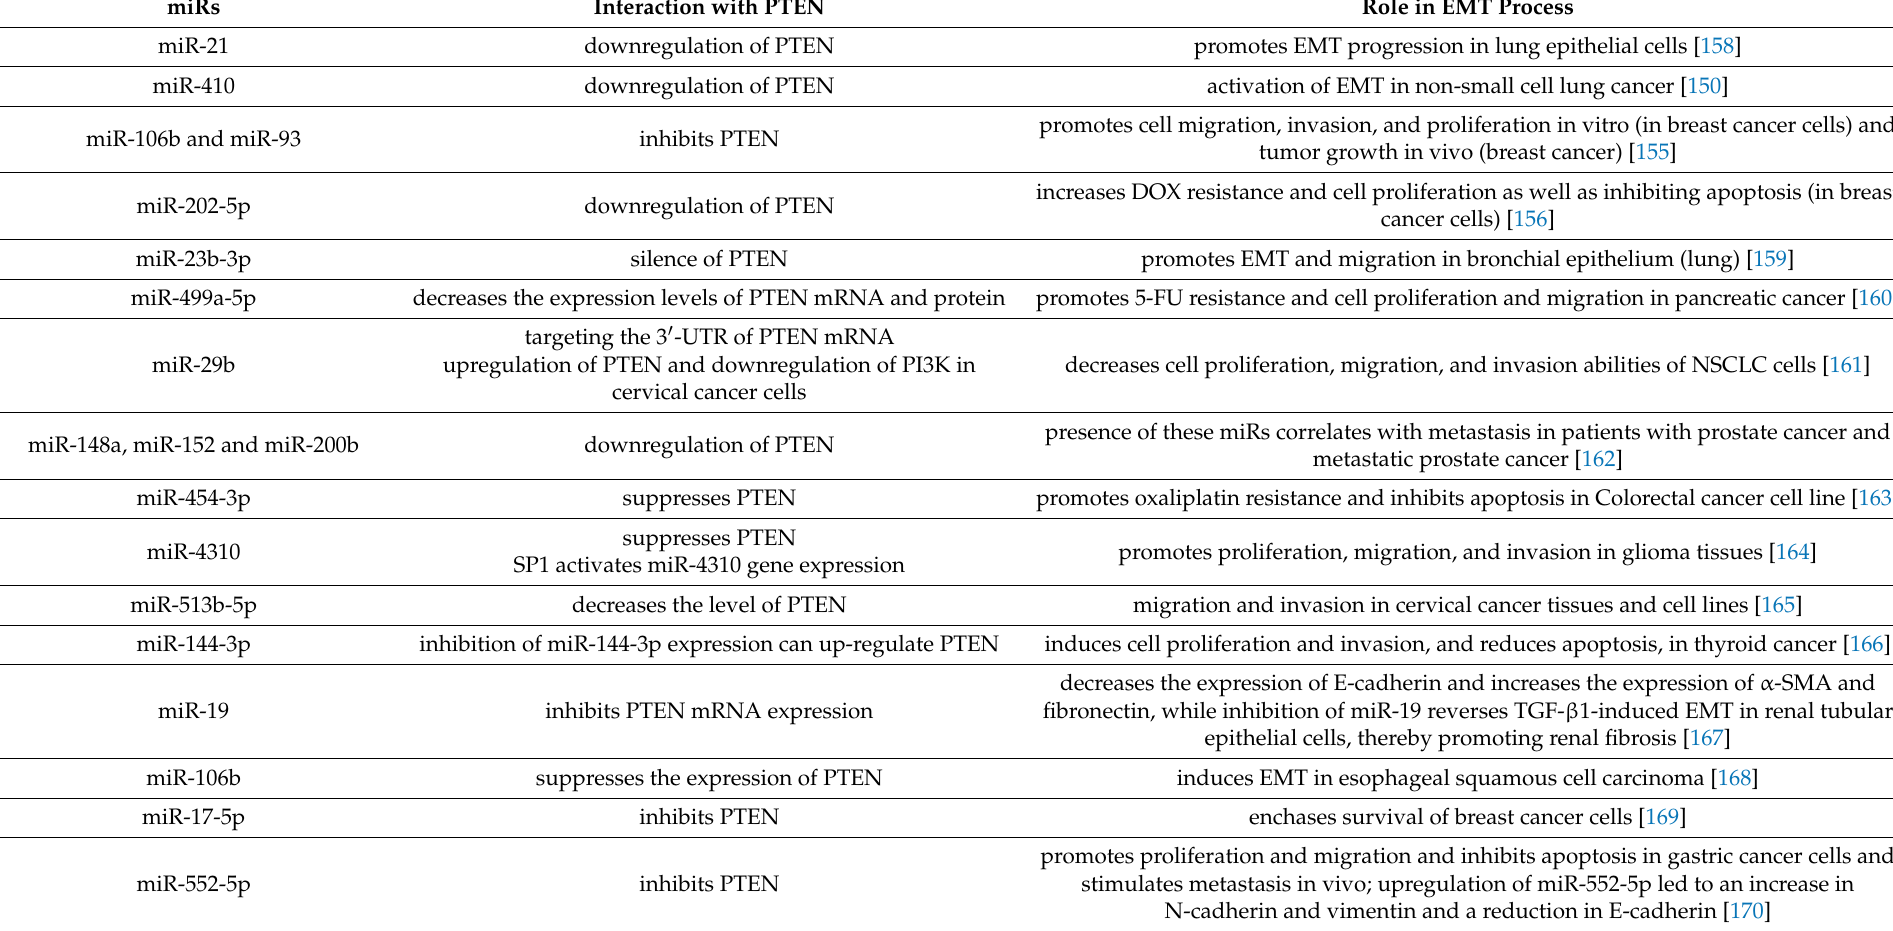
Table 1. miRNAs targeting PTEN